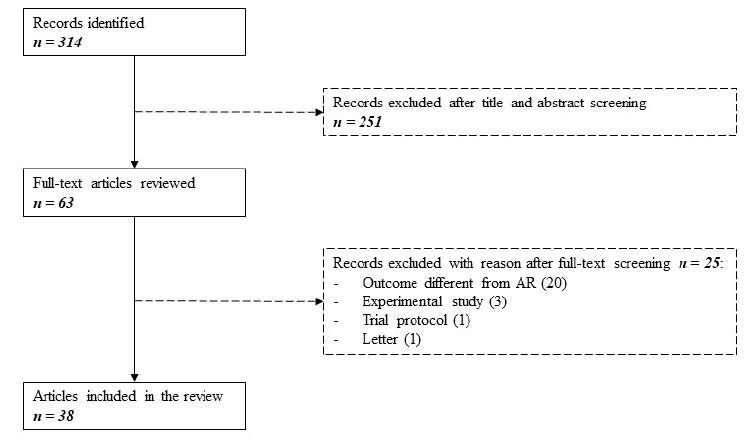
Figure 1. Search flowchart as per PRISMA guidelines. Three hundred fourteen studies were identified